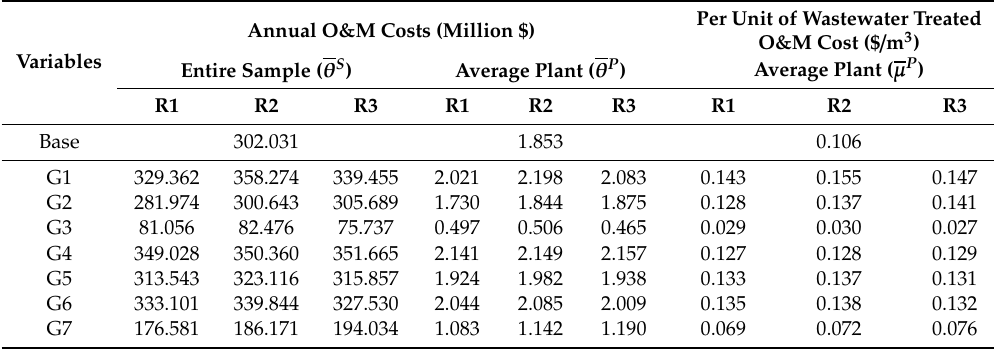
Table 6. Simulated future climate change impacts on wastewater treatment